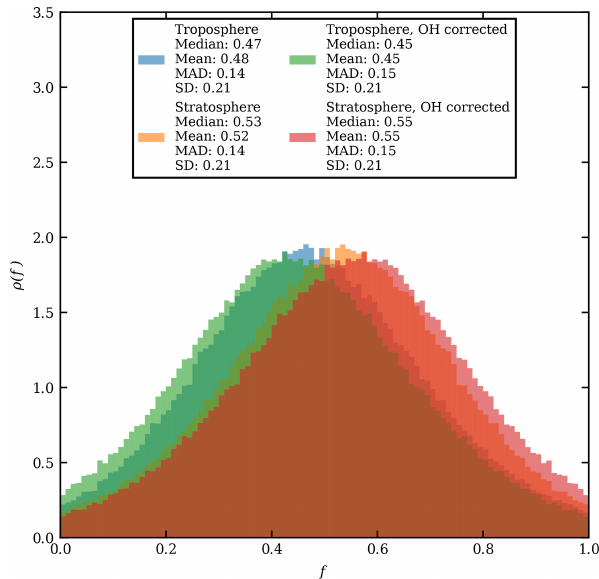
Figure 6. Probability density of the air fraction by volume, as a result of a Monte Carlo simulation. The data are binned into 1% bins. Results with and without a correction for OH are